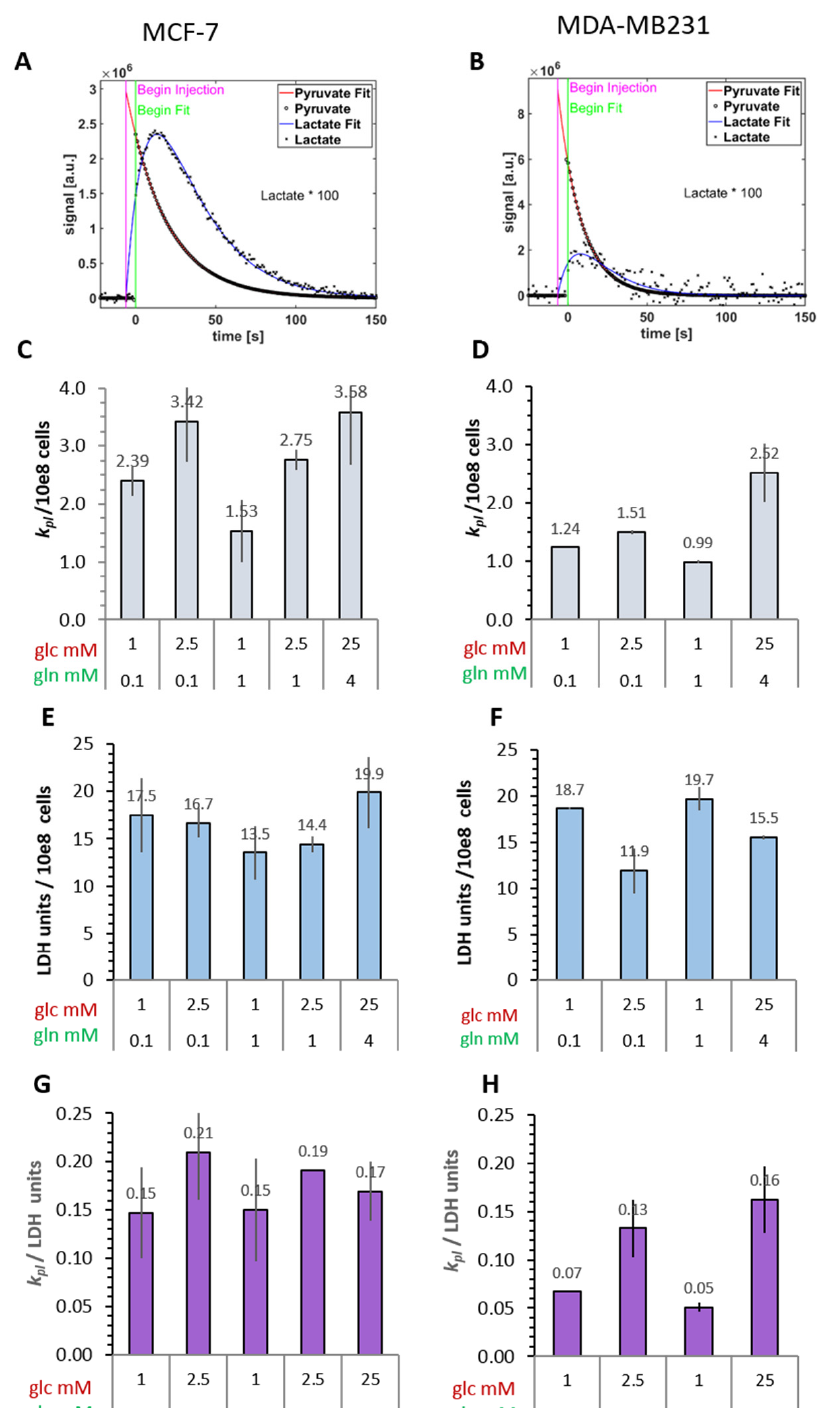
Figure 2. Conversion of hyperpolarized [1- 13 C]pyruvate to [1- 13 C]lactate in MCF-7 and MDA-MB-231 cells. After incubation in the indicated glucose/glutamine conditions for 72 h, cells were trypsinized and suspended in their corresponding conditioned medium for measurements. ( A , B ) Signal time curve of hyperpolarized [1- 13 C]pyruvate and [1- 13 C]lactate extracted from spectra, shown in Figure S1, and the kinetic model fits for obtaining apparent conversation rate constants k pl . Lactate signal time curves are up-scaled 100-fold for better visualization. ( C , D ) Conversion rates of hyperpo- larized 13 C-pyruvate to 13 C-lactate were calculated per cell number and are averages with the s.e.m. of two independent experiments. ( E , F ) Potential LDH activity (V max ) measured in lysates from the same sample after the measurements. ( G , H ) Relationship of k pl to potential LDH